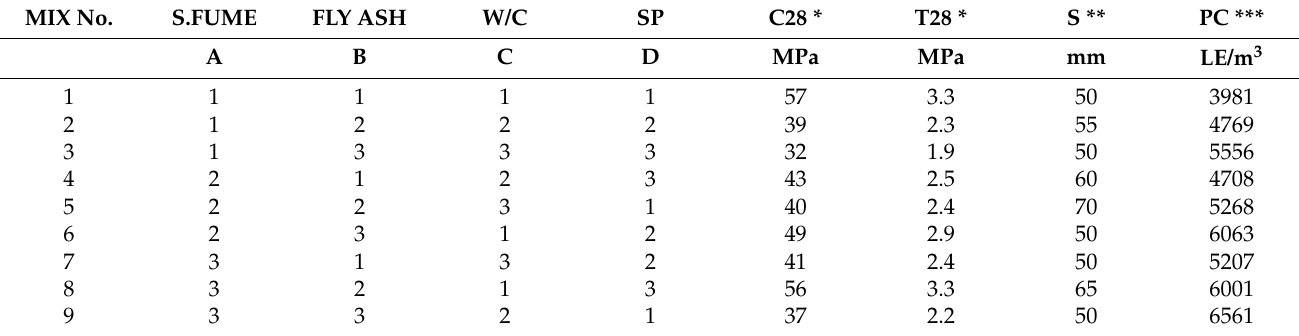
Table 3. Orthogonal array and experimental